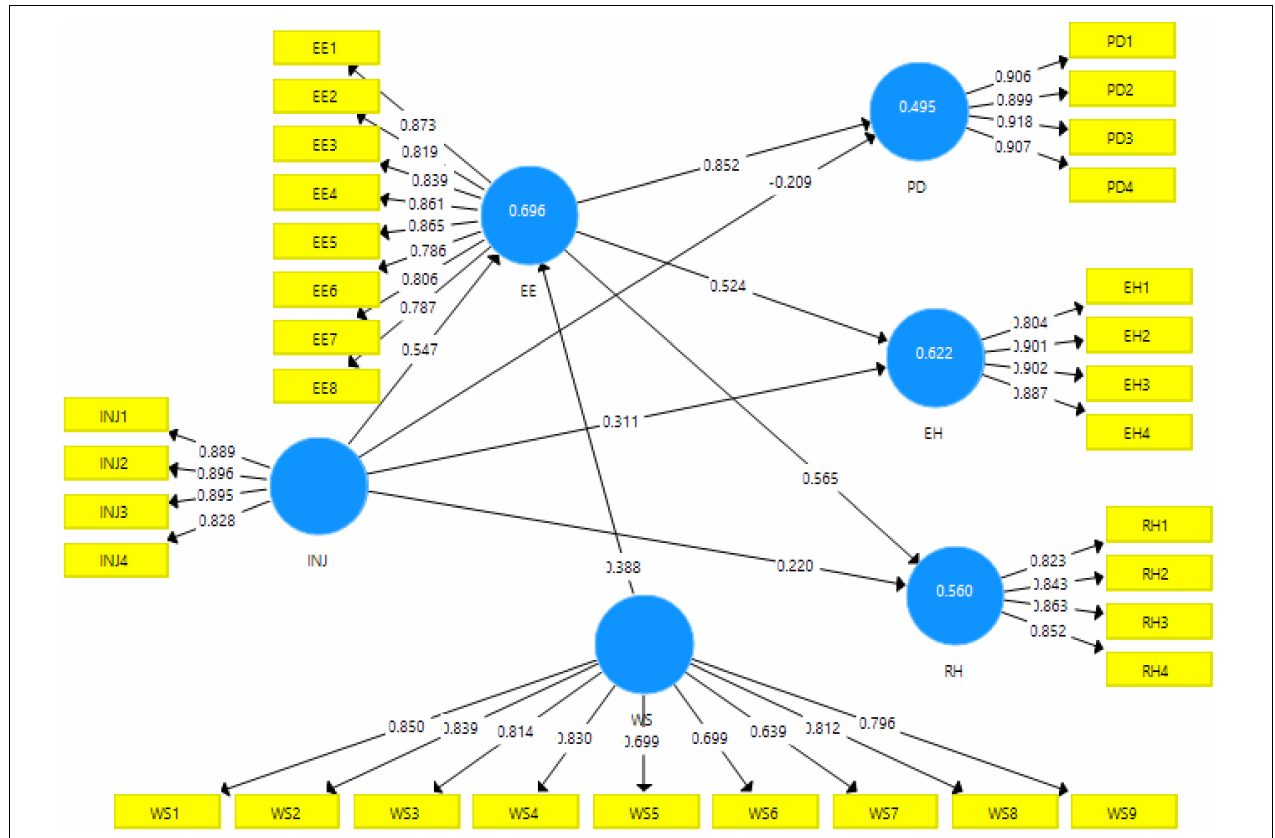
FIGURE 2 | Output of measurement model